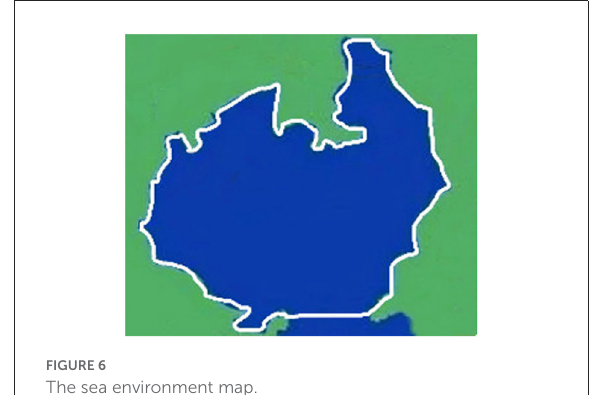
FIGURE6 The sea environment